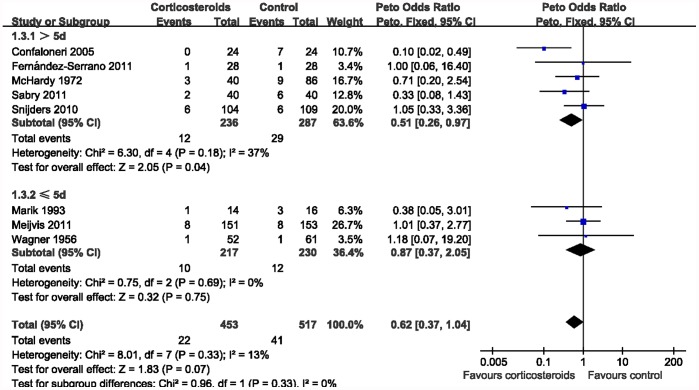
Subgroup analysis according to the duration of corticosteroids treatment.